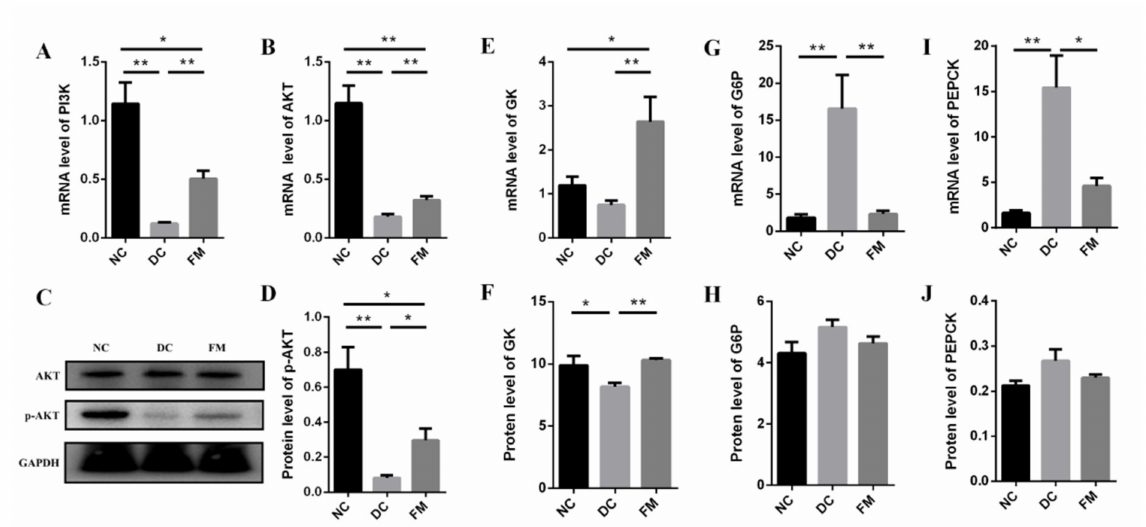
Figure 5. The expression of mRNA and protein of core factors in PI3K/AKT signaling pathway and its downstream effectors: ( A – D ) core factors in PI3K/AKT signaling pathway; ( E , F ) key enzymes in glycolysis; ( G – J ) key enzymes in gluconeogenesis. Data were represented as mean ± SEM. NC, normal control group; DC, diabetic control group; FM, foxtail millet supplementation group; PI3K, phosphatidylinositol-3-kinase; AKT, protein kinase B; G6P, glucose-6-phosphatase; GK, glucose kinase; PEPCK, phosphoenolpyruvate carboxy. Differences between groups were compared using Student’s T -test, * p < 0.05, ** p < 0.01.